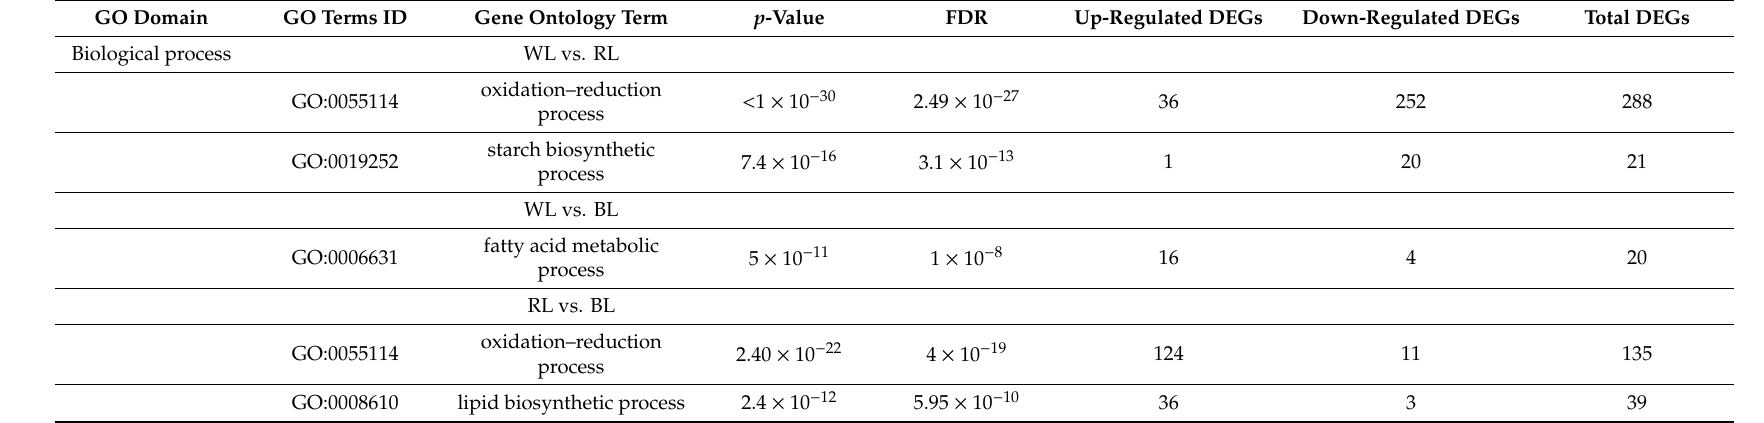
Table 4. Biological process enrichment analyses for DEGs between di ff erent light